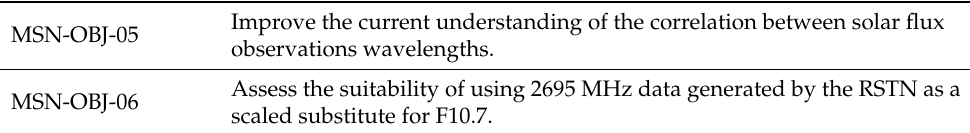
Table 2. Secondary mission objectives of